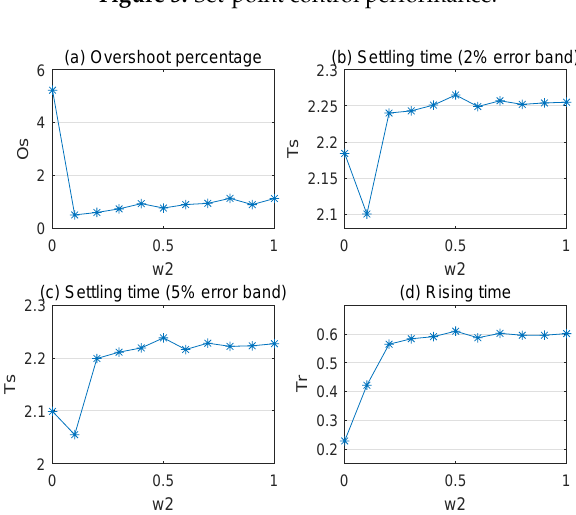
Figure 4. Control performance indicators